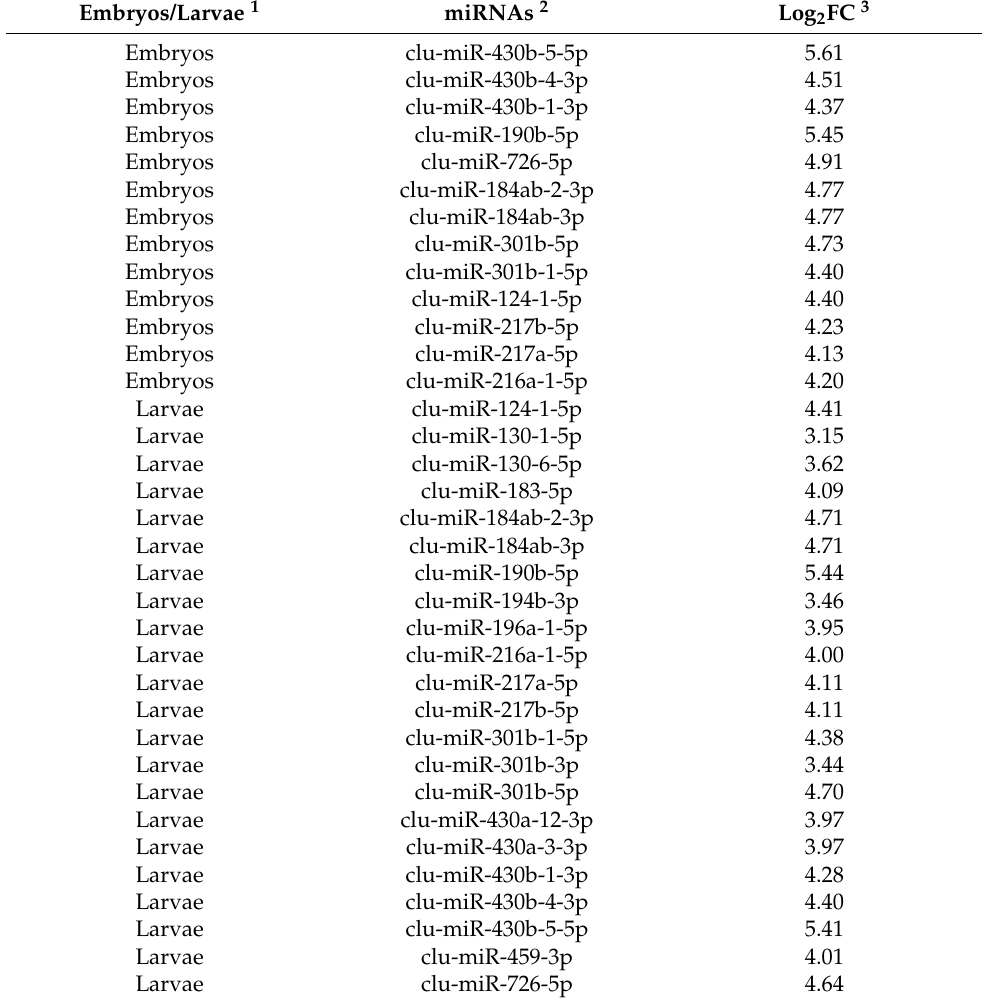
Table 3. Mature miRNAs suggested as highly expressed in embryos or